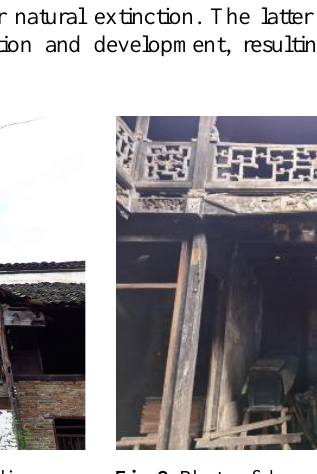
Fig. 1. Photo of damage of ancient building structure.